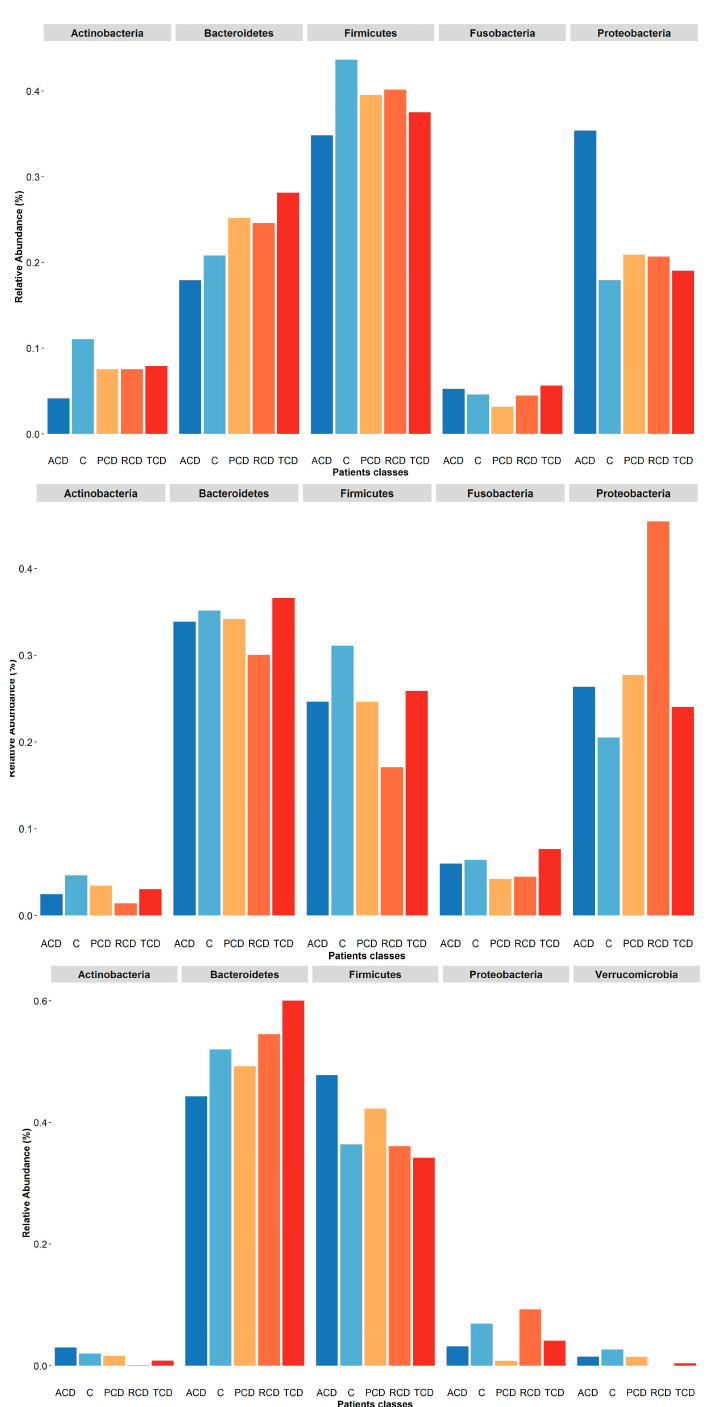
Figure 5. Plot of relative abundances of the five most abundant phyla retrieved in each sample biotype: At mucosal level (upper panel), although Firmicutes is the most abundant phylum, it is reduced in the ACD group as Actinobacteria . A parallel increase of the Proteobacteria is found in this group, while an expansion of Bacteroidetes in the RCD group and a reduction of Fusobacteria in the PCD one are evident. In the salivary samples (central panel), the most abundant phylum is Bacteroidetes . Again, Firmicutes is reduced in the ACD group as Actinobacteria in comparison to the C group. Interestingly, the RCD group shows a decrease of all phyla but Proteobacteria . In the stool samples (lower panel), the two most abundant phyla are Bacteroidetes and Firmicutes , with the other phyla showing negligible values. Noteworthily, the former is decreased in the ACD group and increased in the TCD group in comparison to C, while the latter is increased in the ACD and PCD